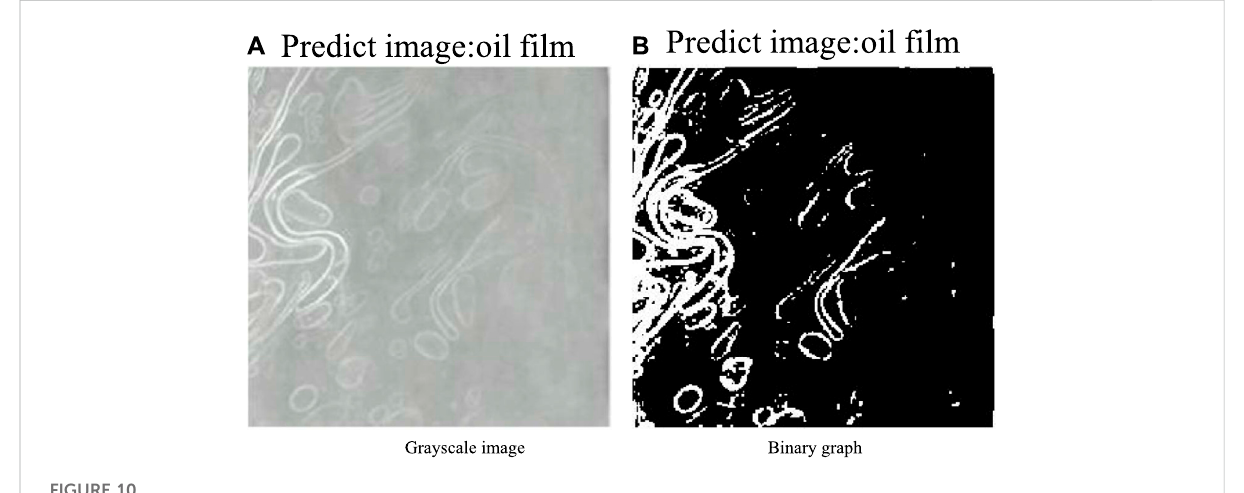
FIGURE 10 Detection results of oil spills. (A) Grayscale image (B) Binary